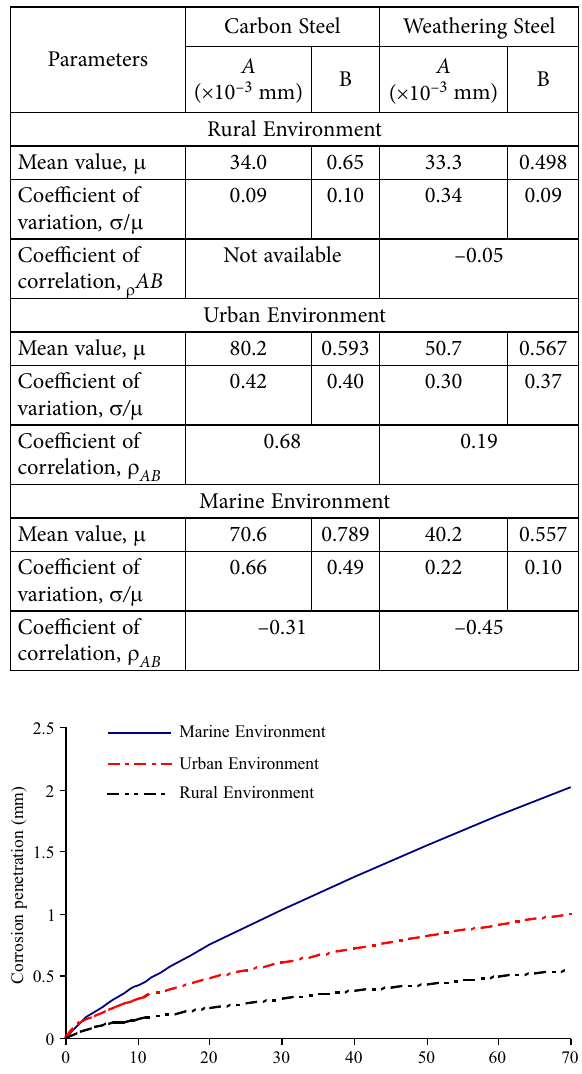
Table 1. Statistical parameters for A and B (Kayser